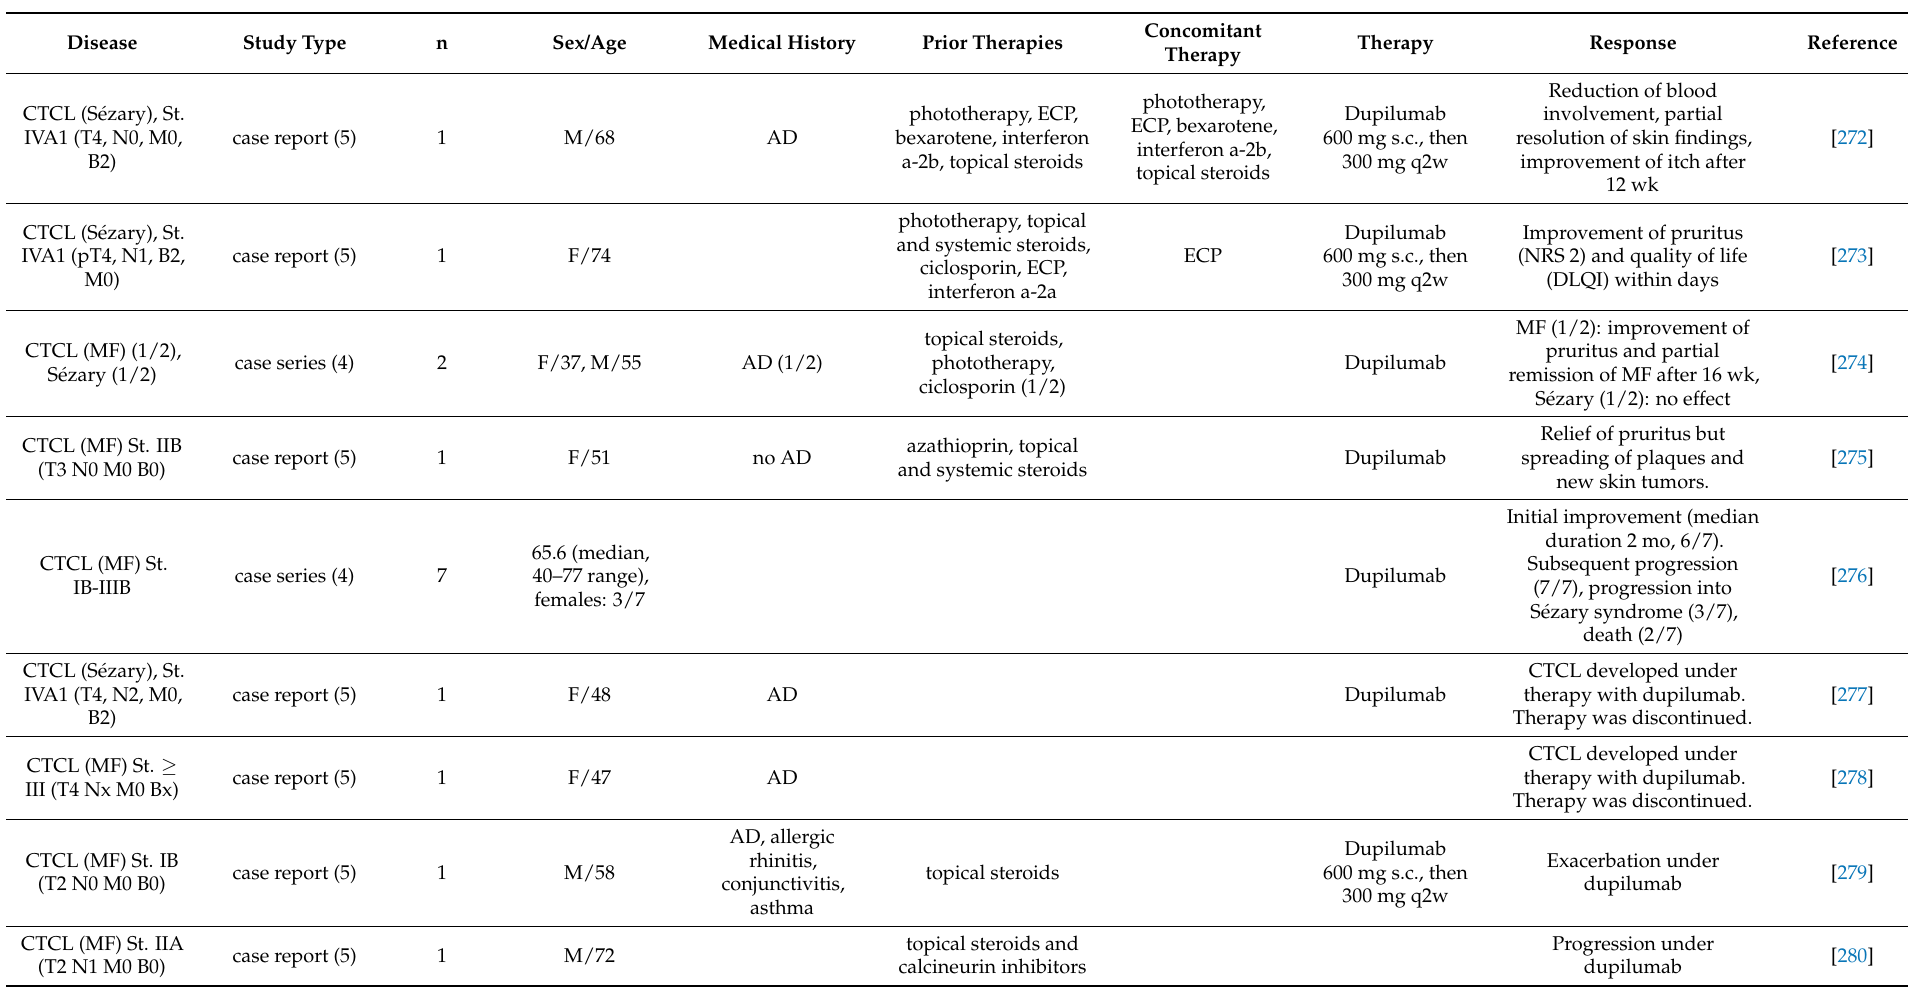
Table 9. Cutaneous